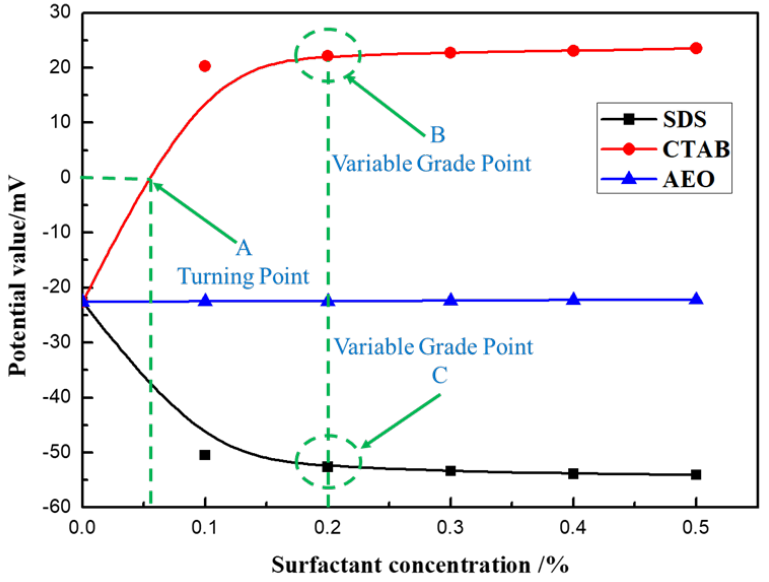
Figure 8. The zeta potential of coal dust under different surfactant concentrations.